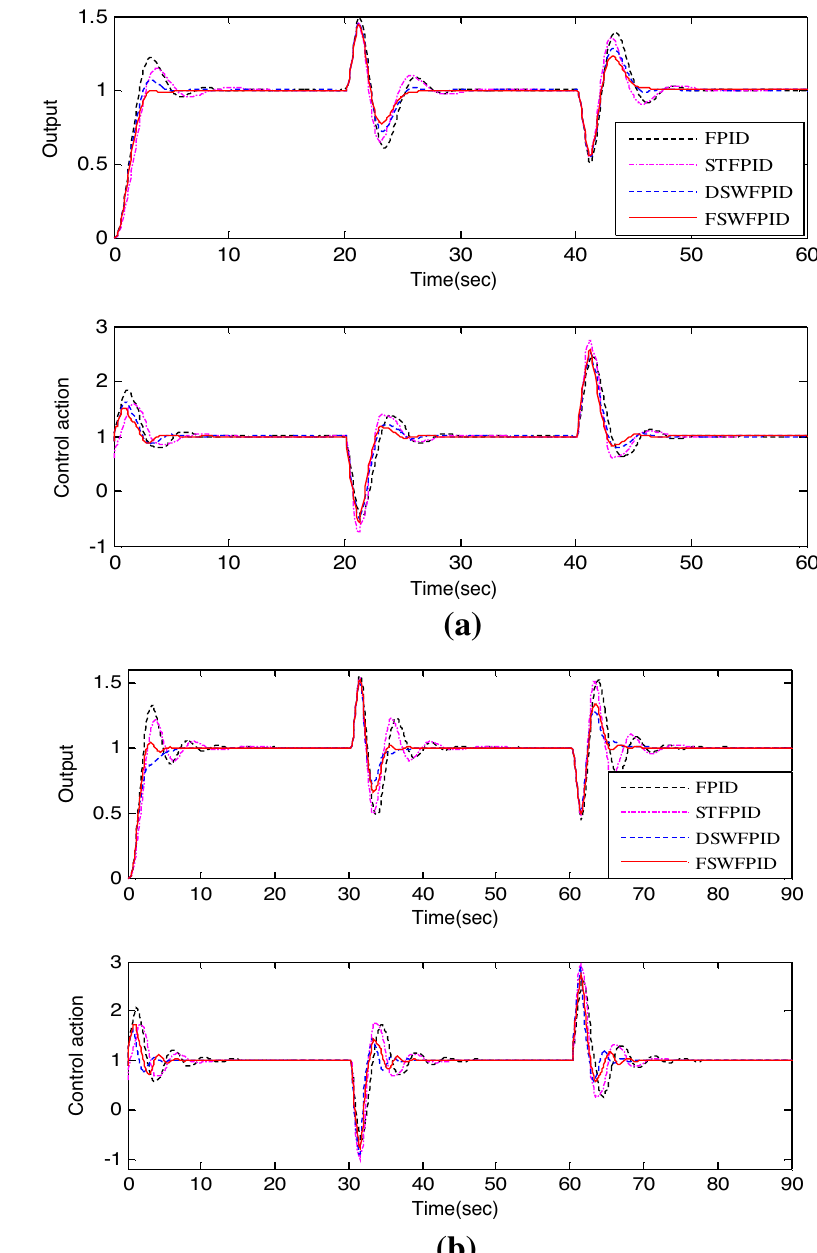
Fig. 10 Responses and control actions for Model II using 49 rules during set point response and with load variation for a L = 0.1 s, b L =